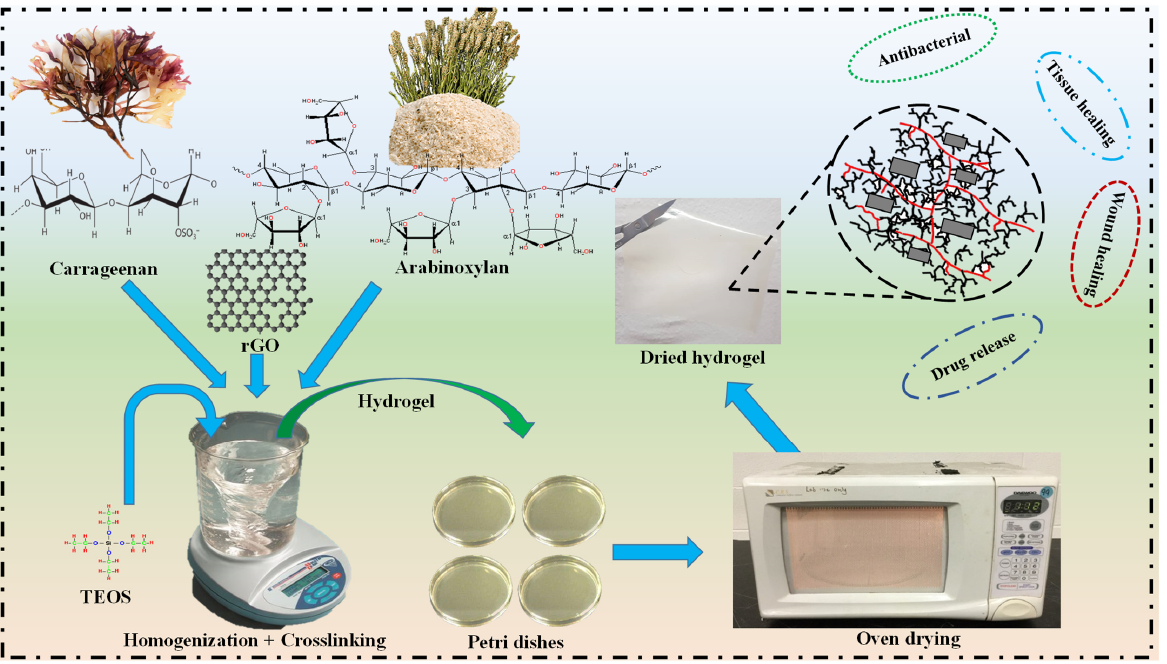
Figure 1. The represents the complete syntheses of composite hydrogel with characterizations and biological activities.